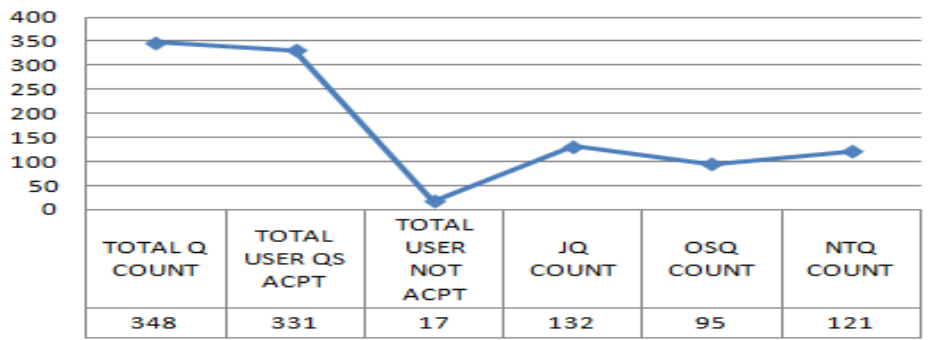
Total Queries With Query